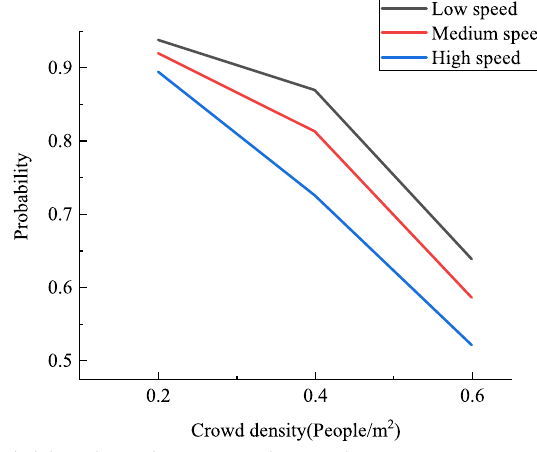
Where A ( x i ) is the annoyance rate at the i -th vibration response. = The discomfort probability values and the calculated annoyance rate values are shown in Table 4. Table 4 denotes that the errors between the proposed discomfort probability values and the calculated annoyance rate results are within 6%, which verifies the ration- ality of the method and provides a reference value for evaluating pedestrian comfort.